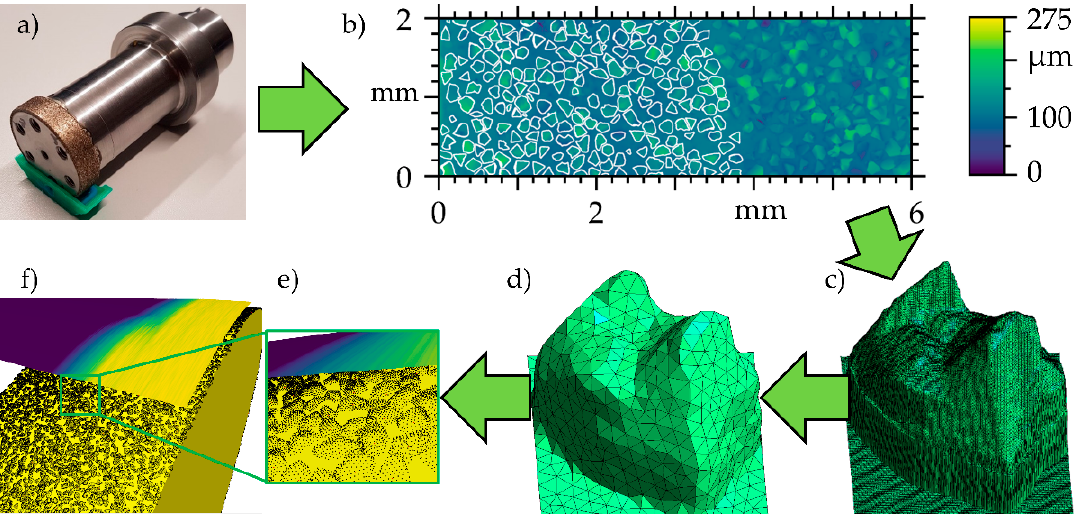
Figure 4. ( a ) Preparation of a grinding wheel topography replica with silicon rubber compound, ( b ) Manual preparation of masks for grain segmentation, ( c ) Grain mesh based on the digitalised grinding wheel containing distorted triangles, ( d ) Remeshing of the grain using the software gmsh yields nearly uniform triangles, ( e ) Topography of the grinding wheel model ( f ) Geometric physically-based grinding simulation for ITG.